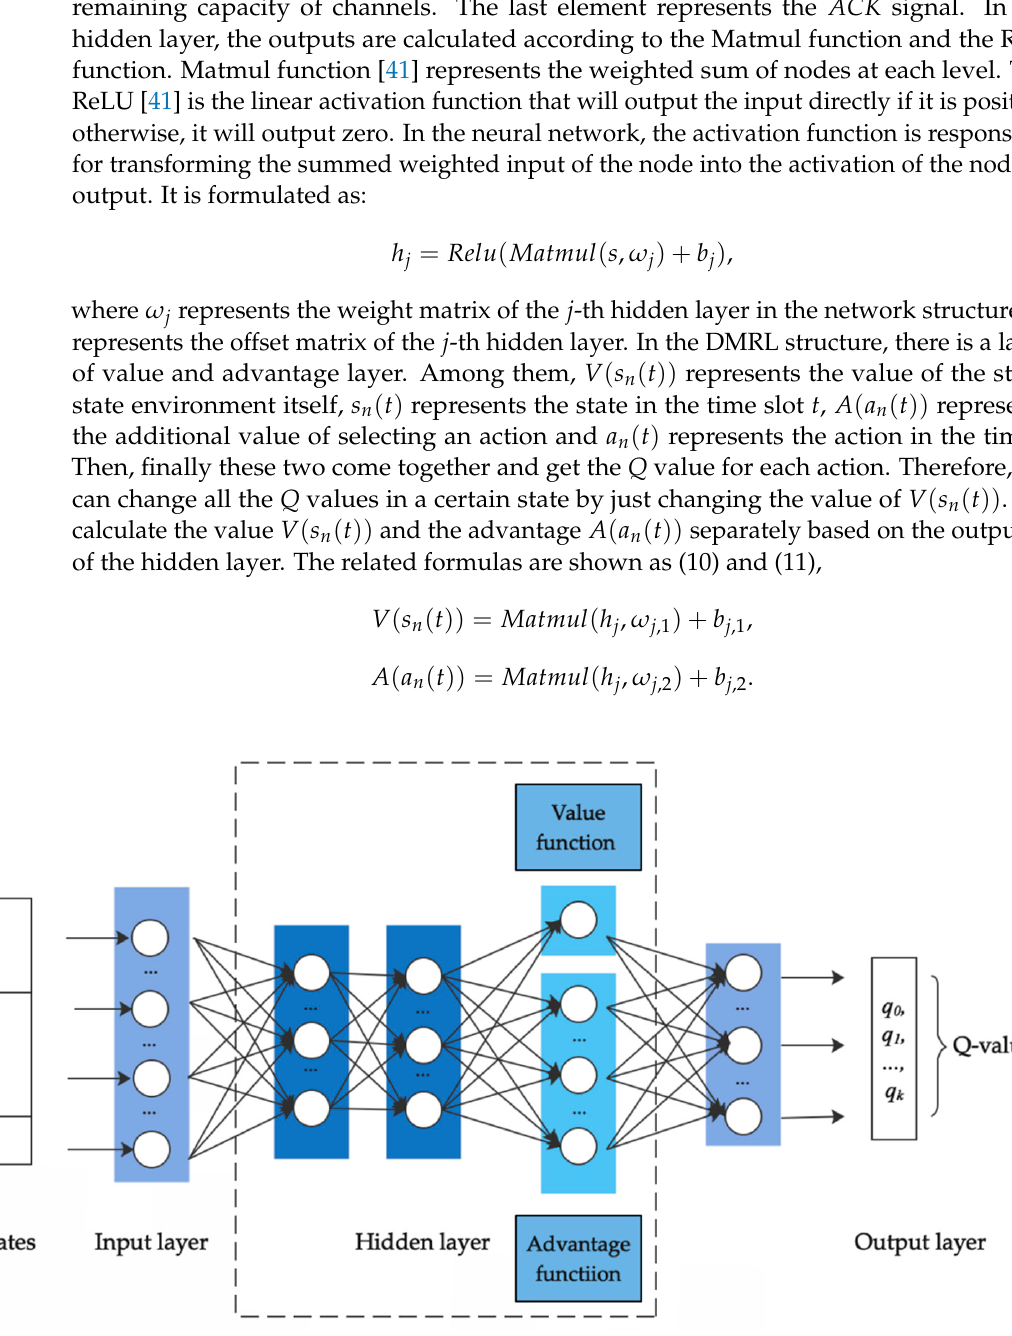
Figure 4 . The network structure of deep multi-user reinforcement learning (DMRL). Figure 4. The network structure of deep multi-user reinforcement learning (DMRL). To avoid the case that only the parameters ω j ,2 and b j ,2 are updated in the proposed DMRL network, (11) is rewritten